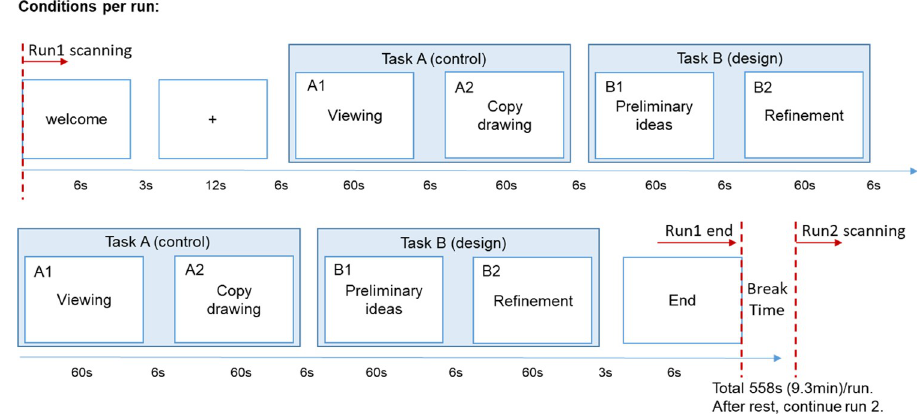
Fig 4. The fMRI experimental